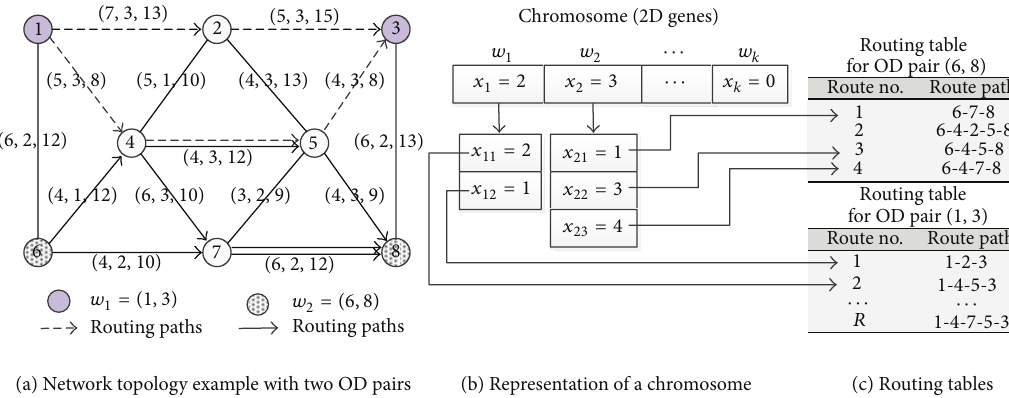
Figure2:Exampleofgenotypecoding:(a)networkgraphwithlinkparameter(cost,delay,andbandwidth),(b)representationofchromosome by using 2D genes, and (c) two routing tables for paths for node 6 to node 8 and paths for node 1 to node 3.